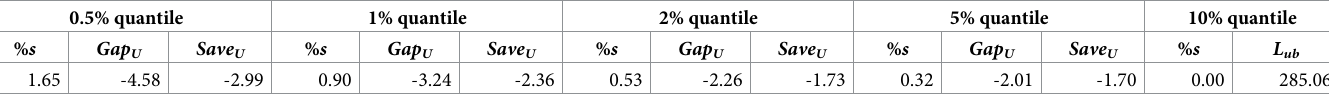
Table 8. Results for BSS in Xiasha,